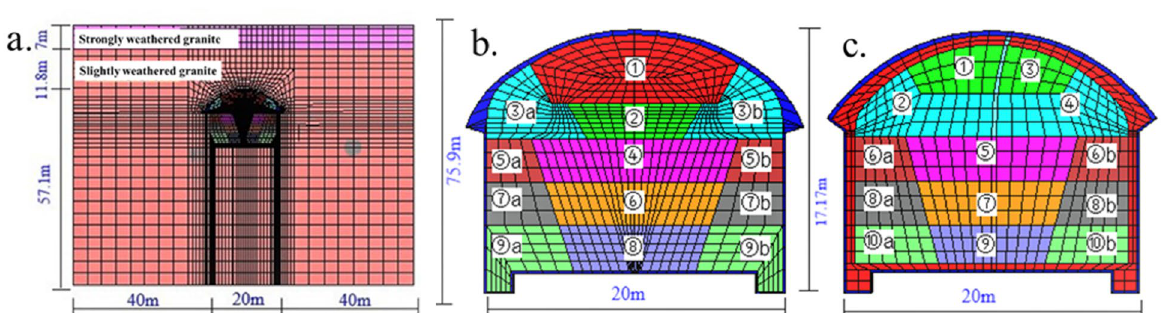
Figure 7. Three-dimensional model of the tunnel. ( a ) Front view of the surrounding rock and tunnel model, ( b ) PCM, and ( c )